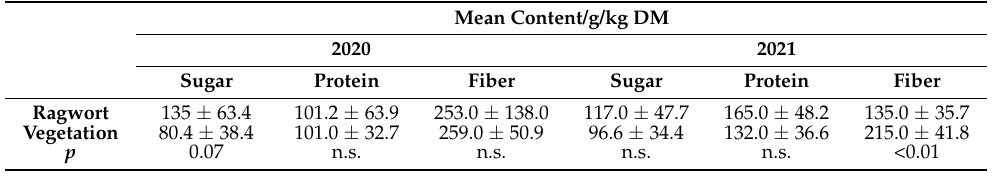
Table 2. Comparison of nutritional parameters in ragwort and vegetation (mean values ± standard deviation) with p values according to two-sided paired t-tests. n.s. = not